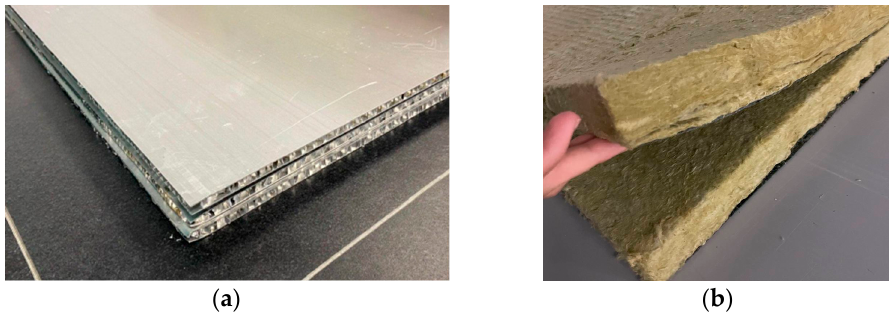
Figure 1. Traditional solution components: ( a ) honeycomb aluminum panels; ( b ) mineral wool layer.